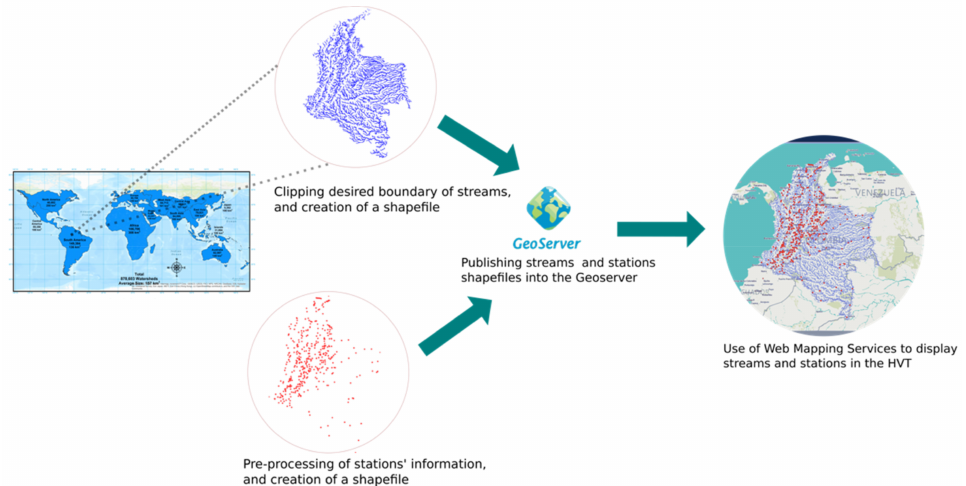
Figure 2. Preprocessing of the streams and gauging stations for their use. The left side of the figure shows the data sources for the stream reaches and associated computed forecasts (top) and the gauging stations and associated observed data (bottom). The circled data represents the clipping of the data sources to the region of interest. These clipped data are then uploaded to the GeoServer, which provides access to the combined